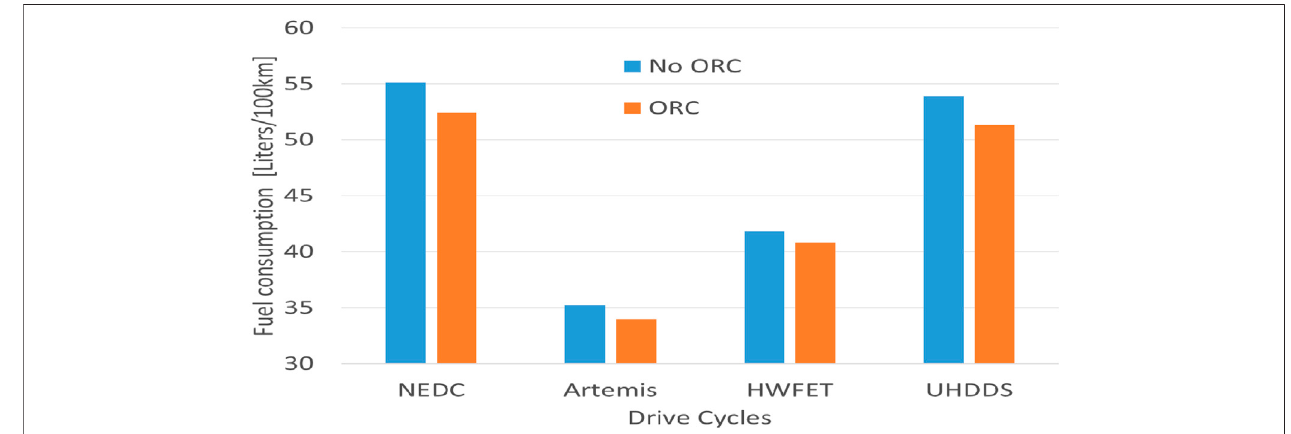
FIGURE 12 | Fuel consumption for comparison between ORC and non-ORC cases for the four drive cycles.